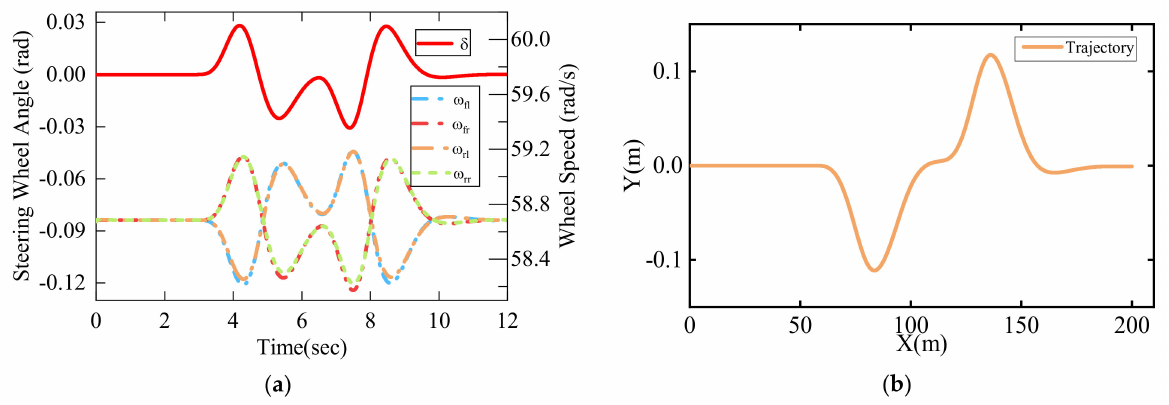
Figure 4. Double-lane change condition ( a ) observer input, including front wheel angle and four-wheel speed; ( b ) vehicle trajectory.